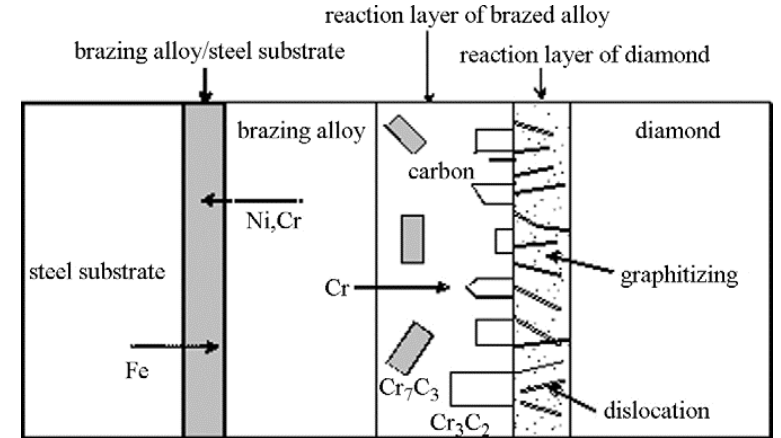
Figure 11. Schematic diagram of the bonding mechanism of a Ni-Cr alloy filler brazing diamond and a steel substrate [21]. Reproduced with permission from Journal of Alloys and Compounds,